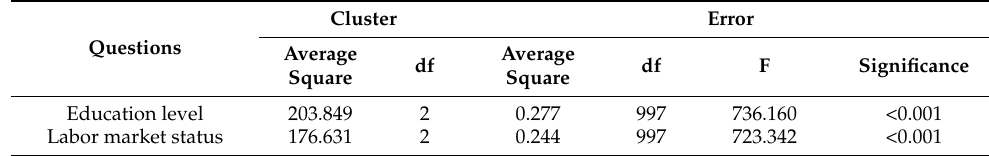
Table 1. ANOVA table for clusters made by education level and labor market status